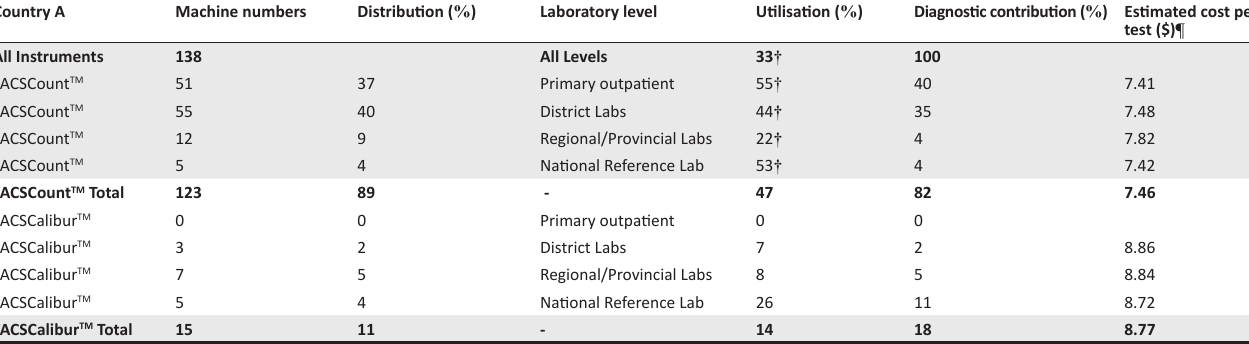
TABLE 3: Country A CD4 Testing Equipment Utilisation. Country A